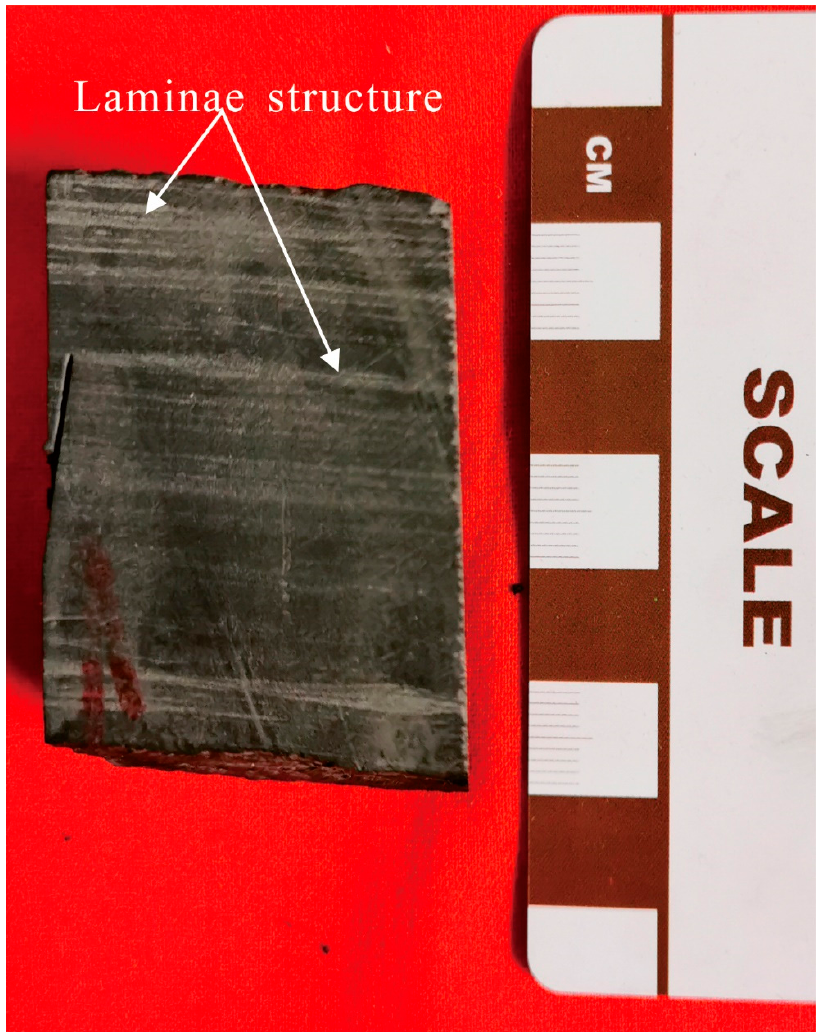
Figure 11. Sedimentary structure characteristics of the TY1-20 sample.